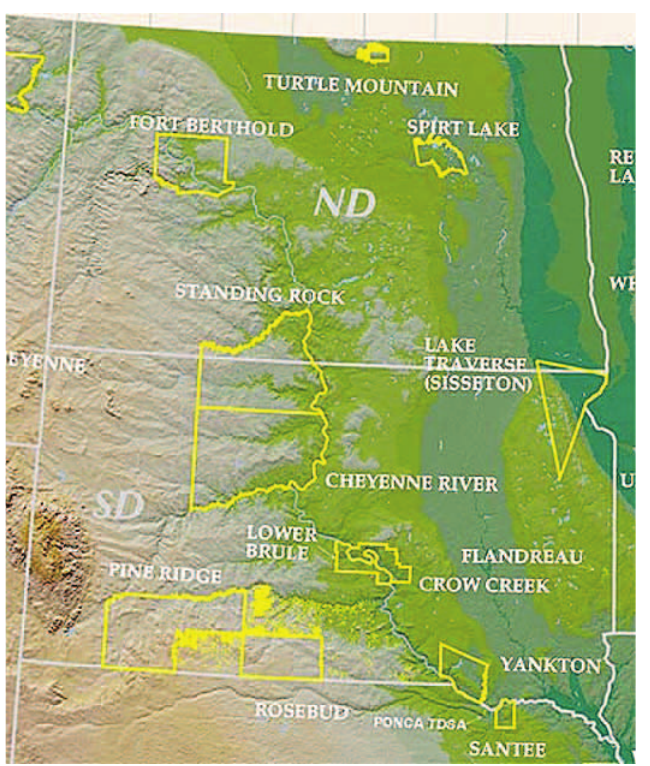
Table 2 – Eleven Indigenous Societies in Comparative World-Systems Analysis Society, People